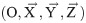
Configuration of head-neck segment rotation.M is a point of the head-neck rigid segment rotating around the resultant center of rotation (CoR) in (O,X→,Y→,Z→). Here, XCoR and YCoR represent respectively horizontal and vertical CoR components, LM is the radius of rotation of point M, θ0 is the initial angular position of point M, relative to the horizontal axis (X), and θ(t) is the angular position of point M, function of time (t), and relative to θ0. Anti-clockwise rotation is positive.